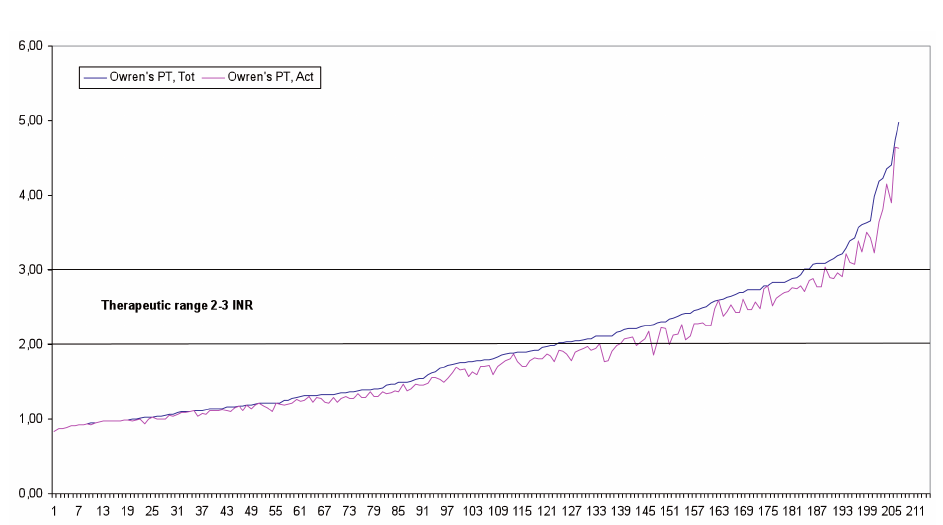
Figure 2. INR TOT and INR ACT values in increasing order from 207 analyzed patient samples on anticoagulation therapy.